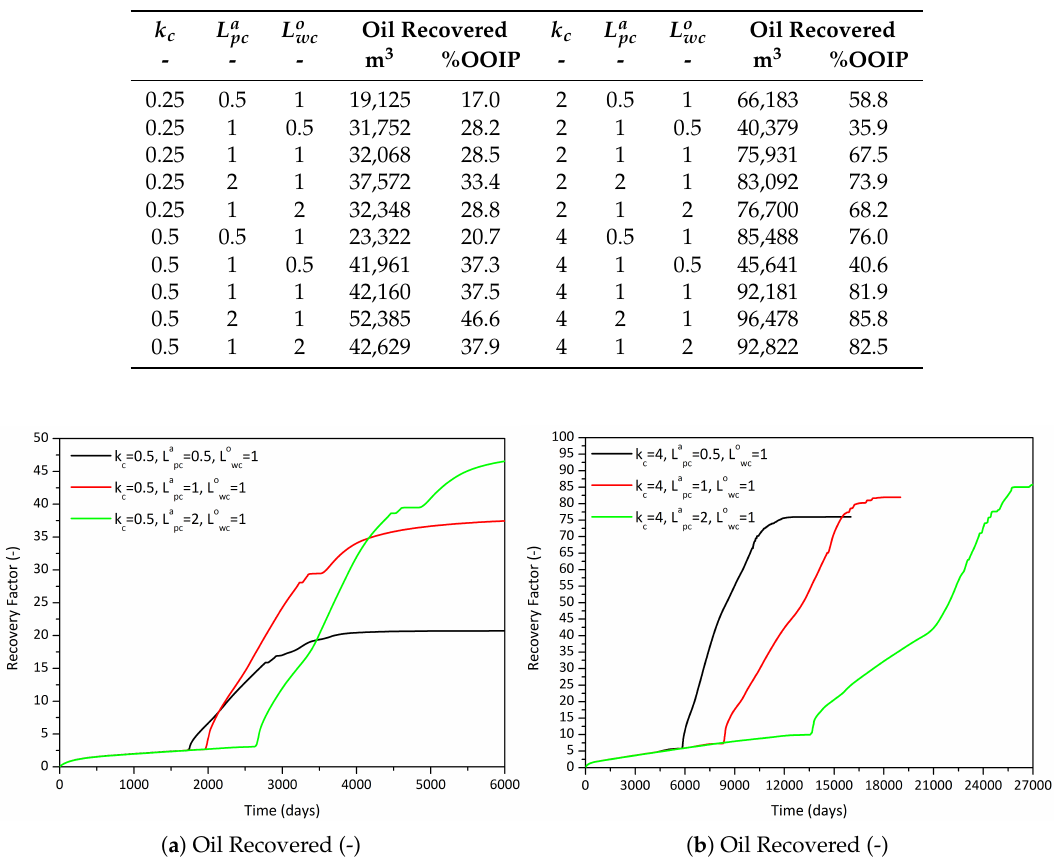
Figure 10. Oil recovered as a function of time for two different phase behaviour parameters (II( − )— a and II(+)— b ) in a surfactant